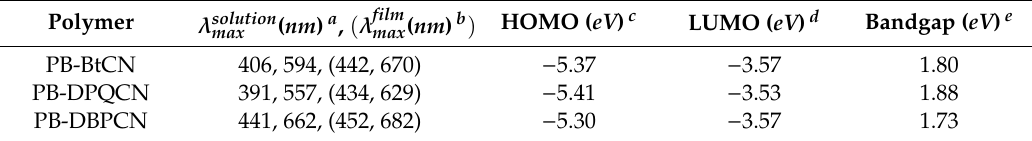
Figure 4. ( a ) CV measurements of the polymers and ( b ) the energy level diagram of the polymers and materials used in this study. Table 1. Summary of the optical and electrochemical properties of the polymers.